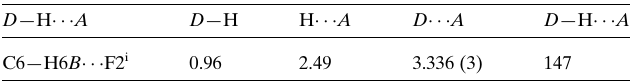
Table 1 Hydrogen-bond geometry (A˚ , (cid:5) ).